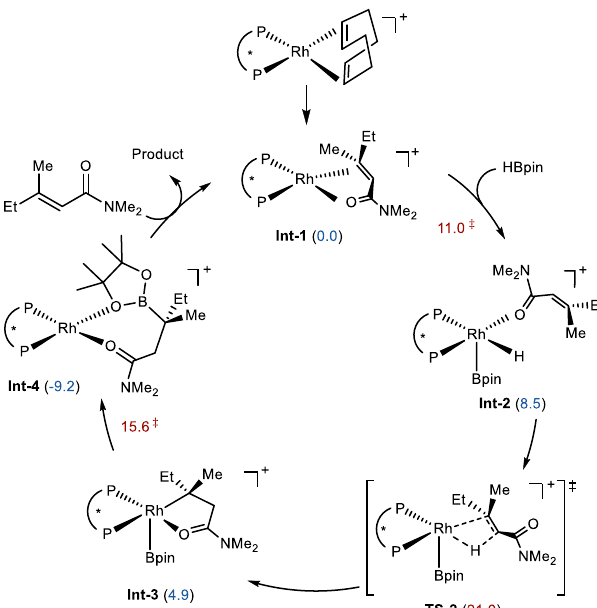
Fig. 6 Proposed mechanism. Catalytic cycle with computed free energies of transition states (red) and intermediates (blue) in kcal/mol.